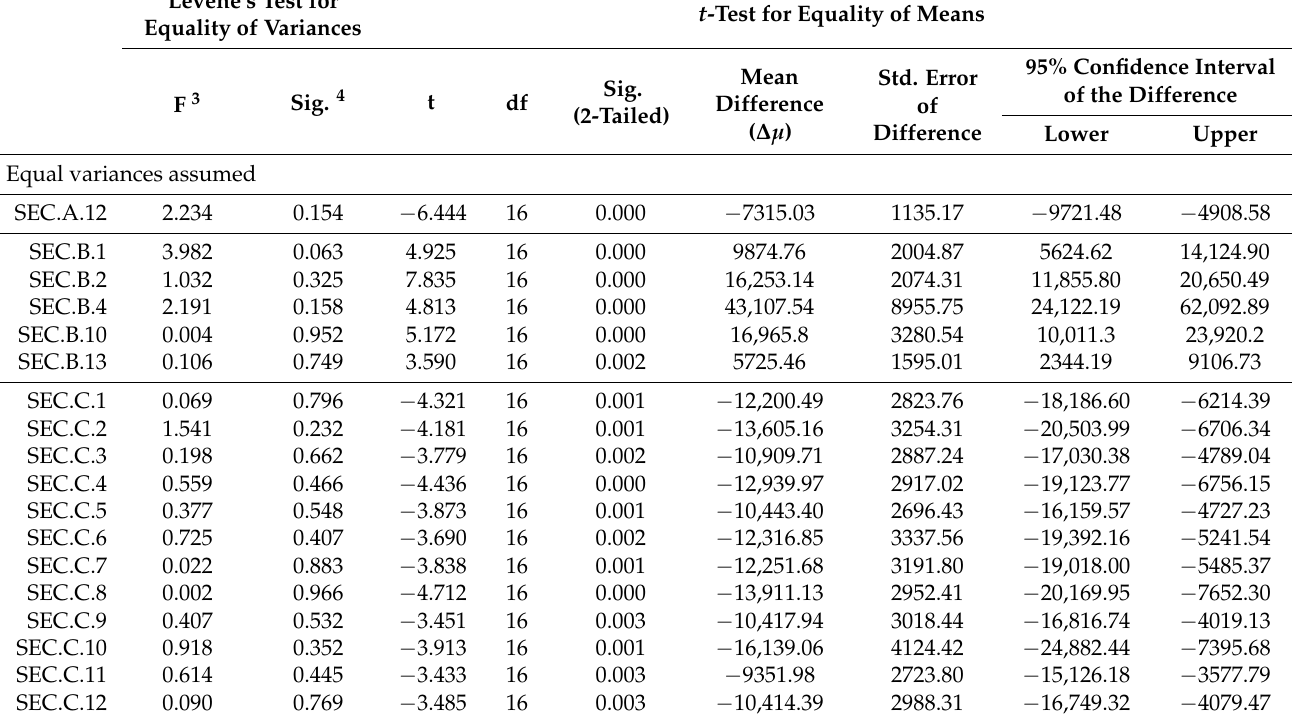
Table A1. Results 1,2 of the Independent Samples t -test for the mean GVA (pLU) differences ∆ µ